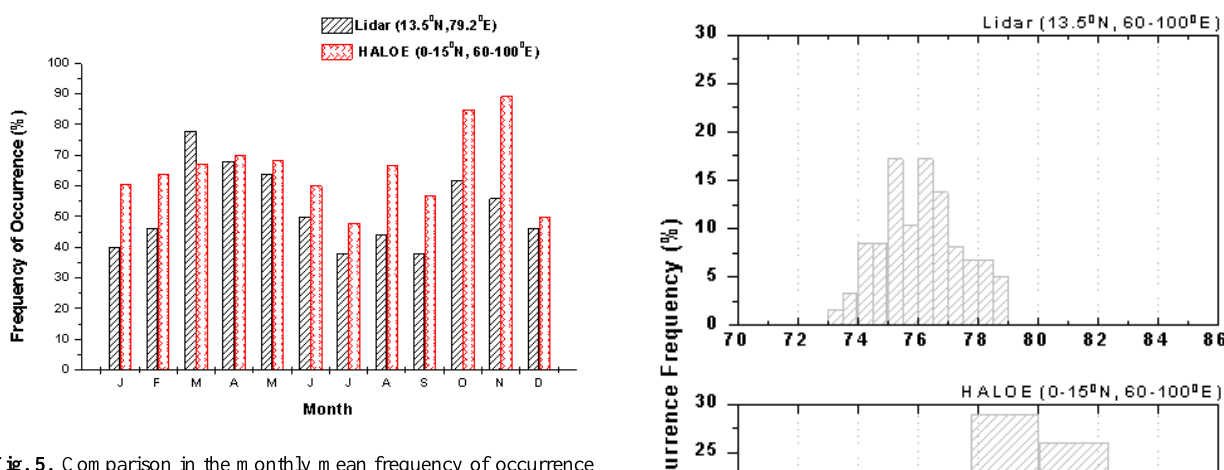
Fig. 5. Comparison in the monthly mean frequency of occurrence of temperature inversion (%) obtained in this work using HALOE data over Indian region (0–15 ◦ N, 60–100 ◦ E) and that of Kumar et al. (2001) obtained by lidar data at Gadanki (13.5 ◦ N, 79.2 ◦ E) taken during the period 1998–2001.